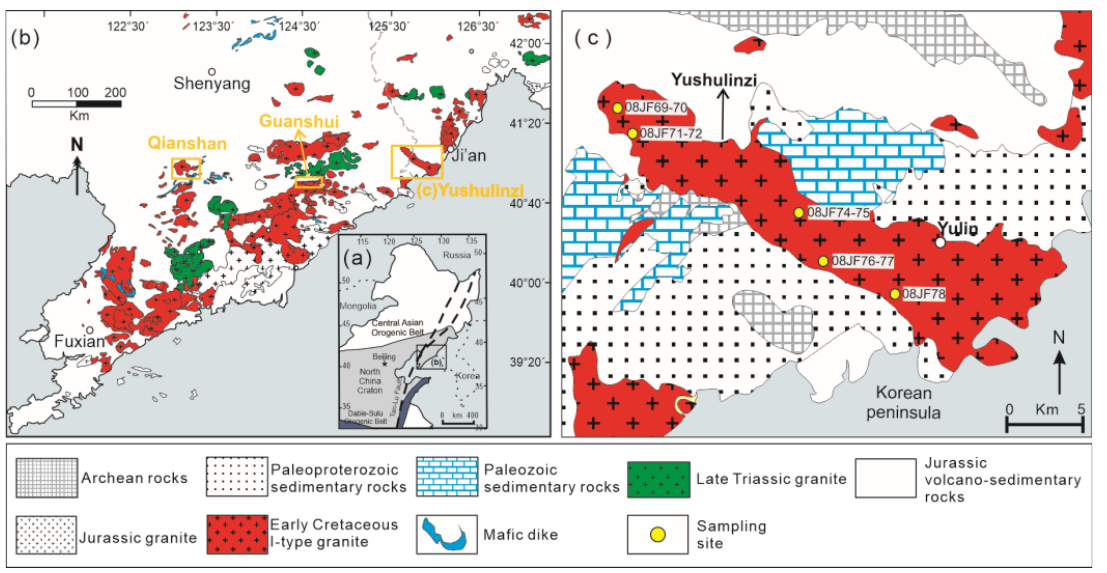
Figure 1. ( a ) Simplified geological map of eastern China; ( b ) Simplified geological map showing the location of the study area and the distributions of the Mesozoic intrusions in the Liaodong Peninsula; ( c ) Geological map of the Yushulinzi pluton showing the sample sites.